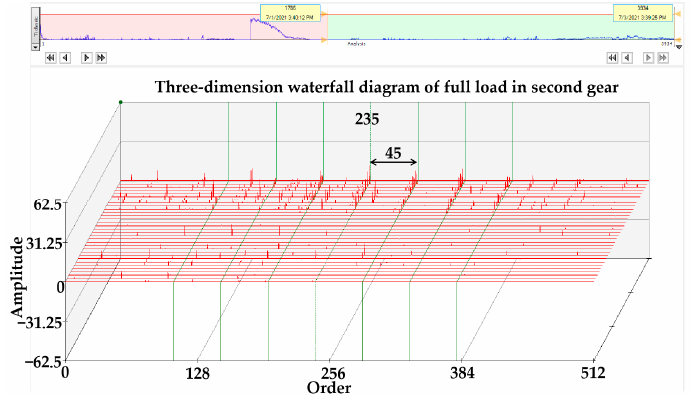
Figure 15. Three-dimension waterfall diagram of full load in second gear.